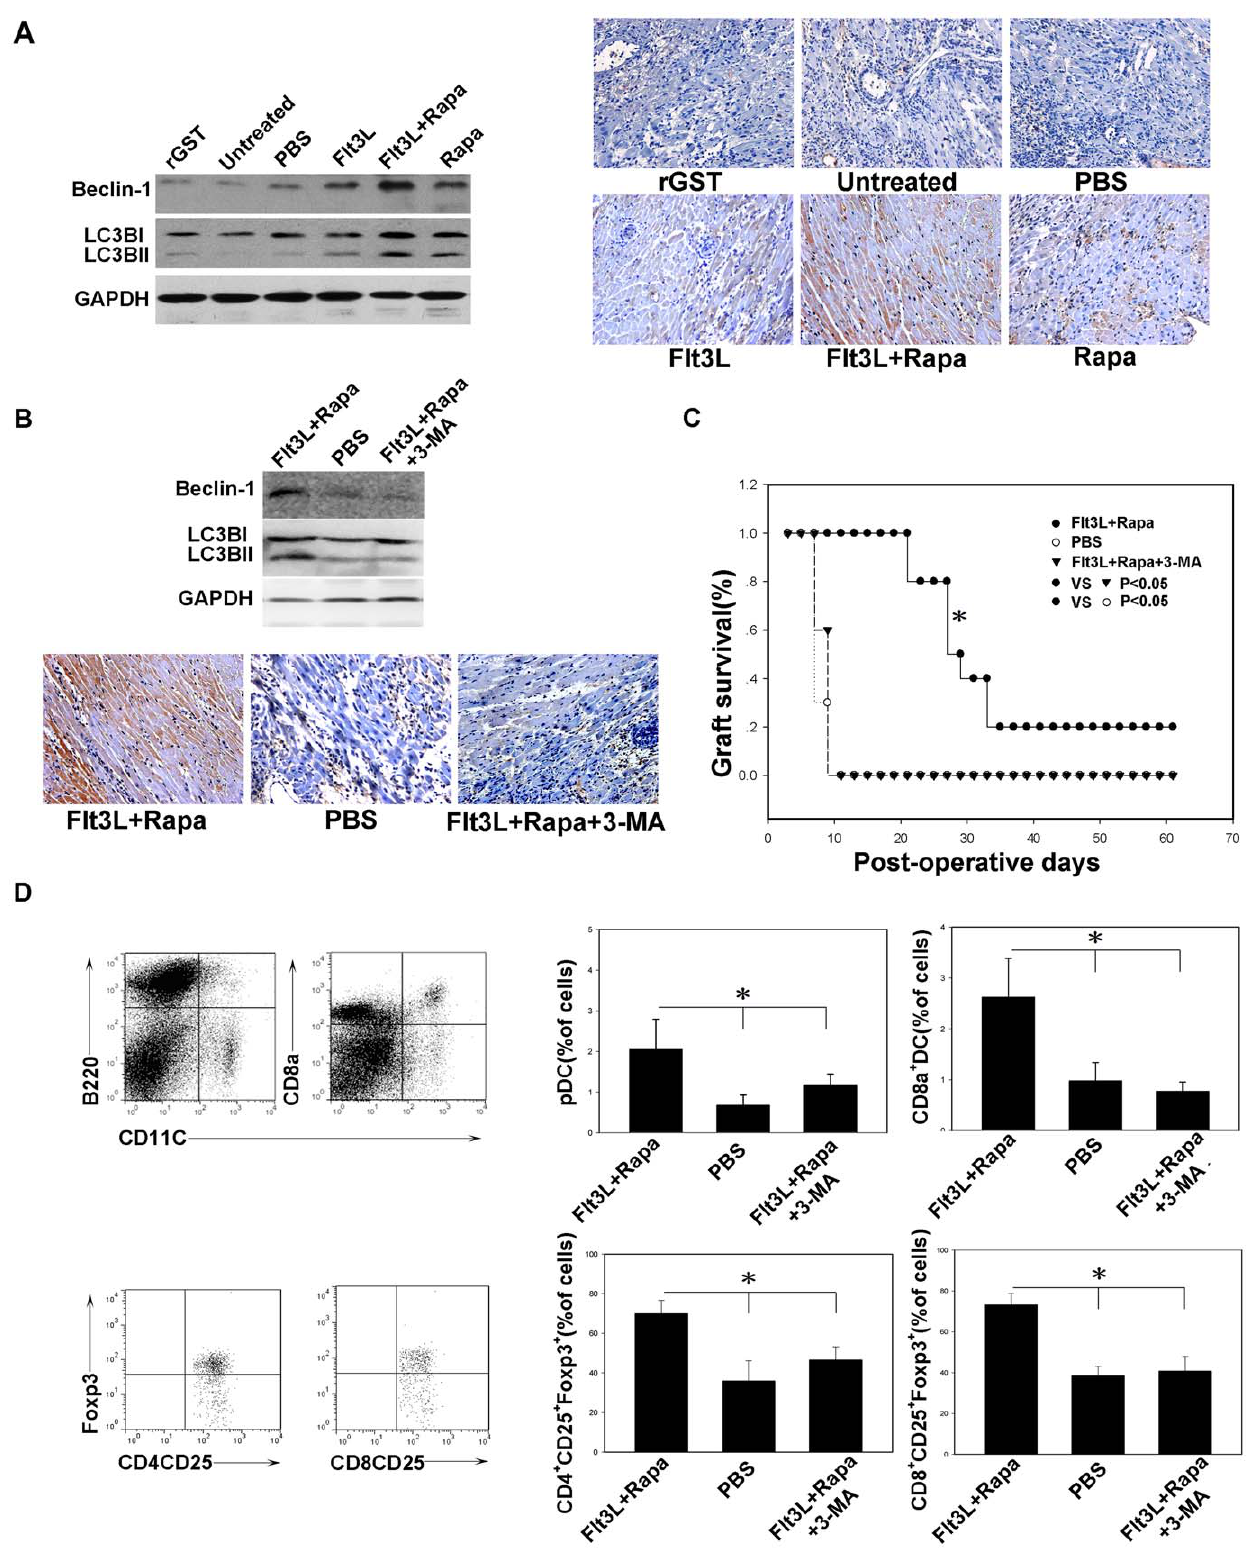
Figure 6. Treatment with Flt3L/Rapa enhances the autophagy in the cardiac allograft. (A, B) The cytoplasmic extracts of cardiac allograft tissue were subjected to Western blotting for evaluating the expression level of Beclin-1 and LC3B, Immunohistochemistry was conducted for examining the expression of Beclin-1 by the cardiac allograft of each group (original magnification, 6 200). (C) Heart allograft survival. The cardiac allograft survival time in recipients treated with Flt3L/Rapa and 3-MA (24 mg/kg, i.p, 5, 10, 15 days) was significant shorter than that of the recipients treated with Flt3L/Rapa (* P , 0.05). (D) The percentage of pDC, CD8a + DC, CD4 + CD25 + Foxp3 + and CD8 + CD25 + Foxp3 + T cells was assessed by FACS